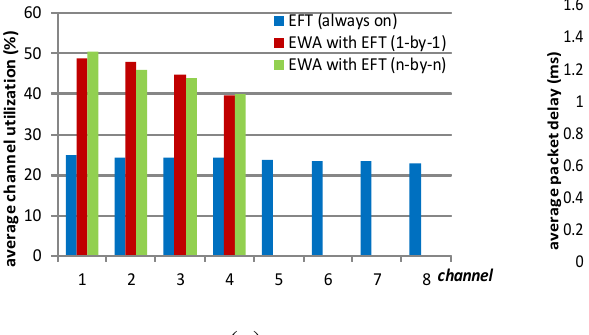
Average channel utilization & Average packet delay. ( a ) Average channel utilization; ( b ) Average packet